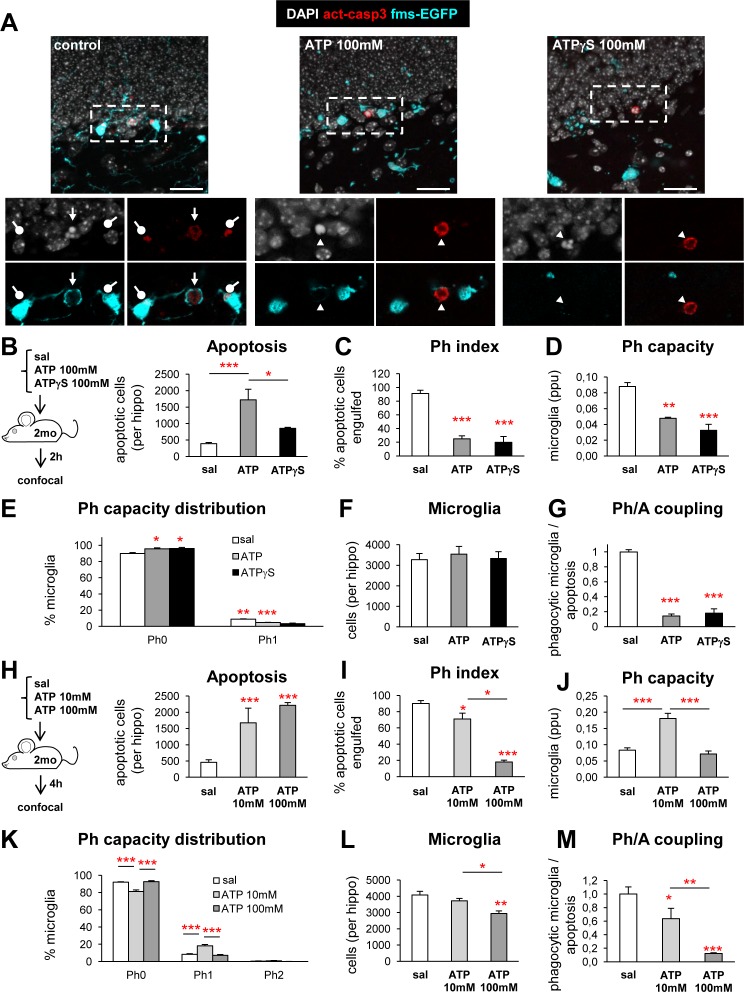
ATP impairs microglial phagocytosis in vivo.(A) Representative confocal z-stacks of saline, 100 mM ATP and 100 mM ATPγS (2 hpi) DG labeled with DAPI (nuclear morphology, white), activated caspase 3 (act-casp3+, red, for apoptotic cells), and fms-EGFP (cyan, microglia). Arrow points to a phagocytosed apoptotic cell, whereas arrowheads point to nonphagocytosed apoptotic cells. Activated-caspase 3 puncta within microglia are labeled with a round-ended arrow. (B, H) Experimental designs (B, 100 mM of ATP and ATPγS, 2 h; H, 10 and 100 mM ATP, 4 h; n = 3–4 per group) and number of apoptotic (pyknotic/karyorrhectic and act-casp3+) in the septal DG (n = 3–4 per group). No changes in the volume of the DG were found in either experiment (S11C Fig). (C, I) Ph index in the septal DG (in % of apoptotic cells). (D, J) Weighted Ph capacity of hippocampal microglia (in ppu). (E, K) Histogram showing the Ph capacity distribution of microglia (in % of cells) in the septal DG. (F, L) Total number of microglial cells (fms-EGFP+) in the septal DG. (G, M) Ph/A coupling (in fold change) in the septal DG. Bars represent mean ± SEM, * indicates p < 0.05, ** indicates p < 0.01, and *** indicates p < 0.001 by Holm-Sidak posthoc test after one-way ANOVA were significant at p < 0.05. Scale bars = 50 μm, z = 11.9 μm (control, ATP), 9.8 μm (ATPγs). Inserts are single plane images of the corresponding confocal z-stacks. Underlying data is shown in S1 Data.